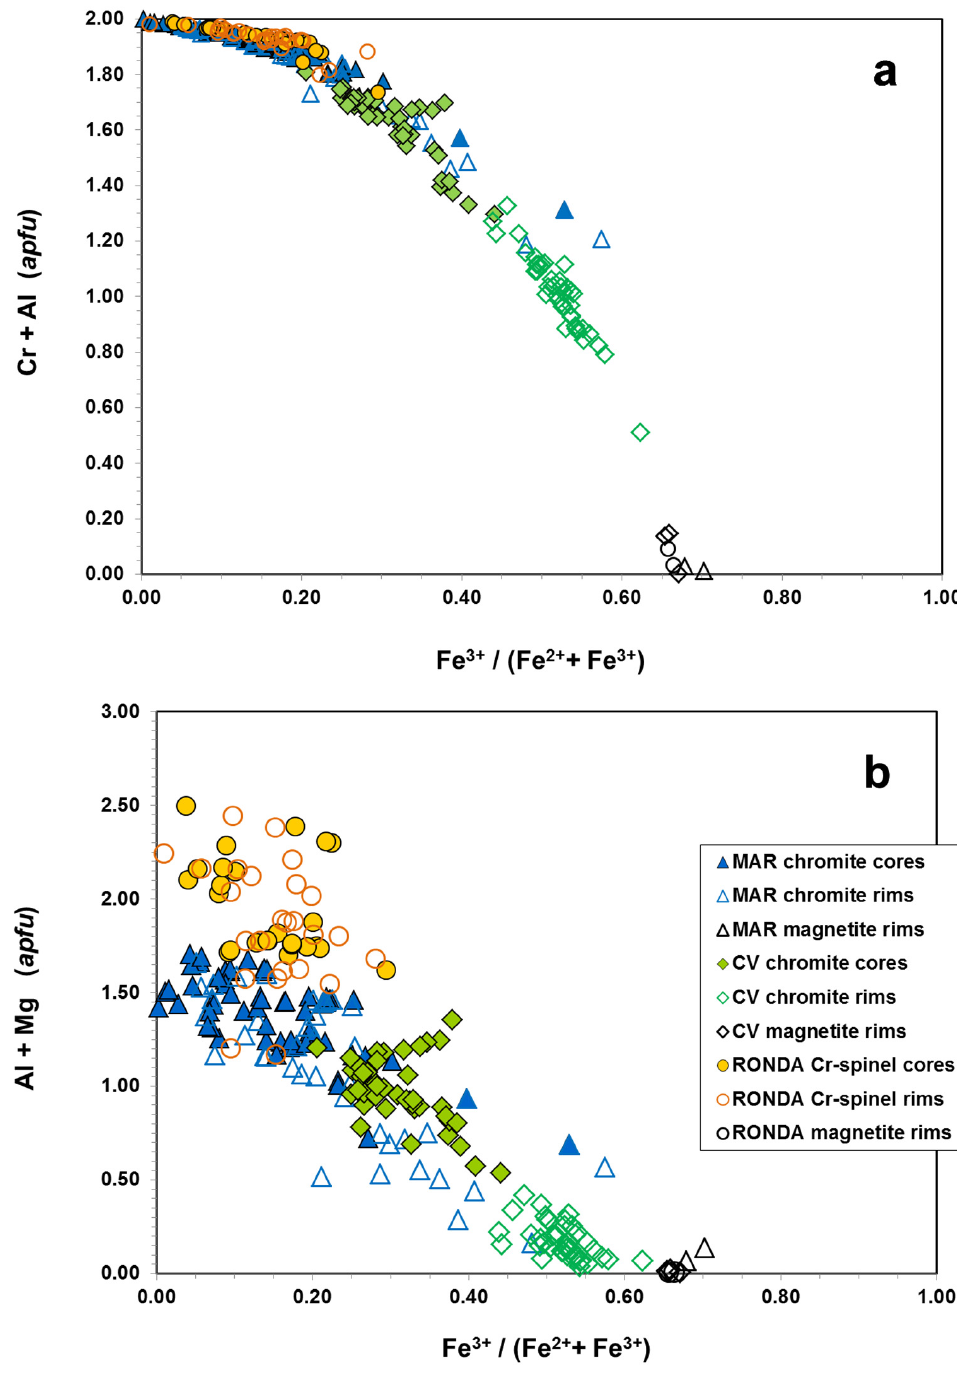
Figure 6. Oxidation trends of the MAR magnesiochromites, CV chromites, and Ronda chromian spinels: ( a ) (Cr + Al) vs. Fe 3+ /(Fe 2+ + Fe 3+ ) and ( b ) (Al + Mg) vs. Fe 3+ /(Fe 2+ + Fe 3+ ).